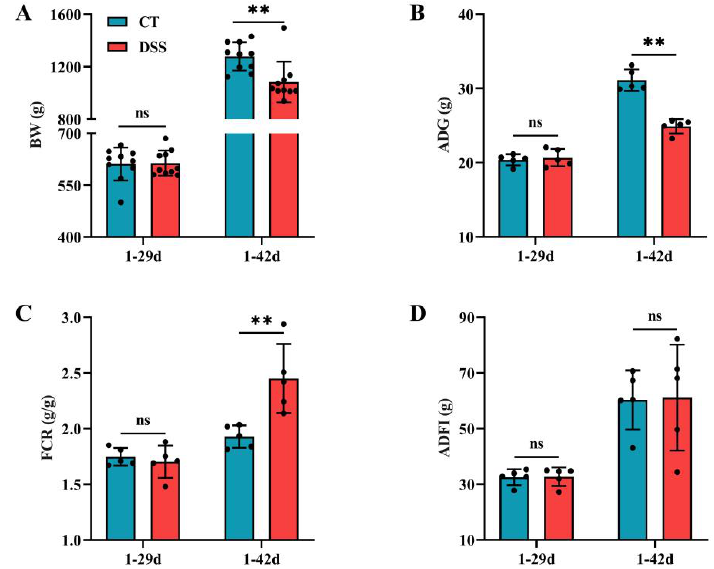
Figure 3. Effects of oral gavage of DSS on the growth performance of broilers: ( A ) BW at two different time points (1–29d and 1–42d) (n = 10 per group); ( B ) ADG at two different time points (1–29d and 1–42d) (n = 5 per group); ( C ) FCR at two different time points (1–29d and 1–42d) (n = 5 per group); and ( D ) ADFI at two different time points (1–29d and 1–42d) (n = 5 per group). Values are means ± SD. ** p < 0.01; ns: not significant ( p > 0.05). BW: body weight; ADG: average daily gain; FCR: feed conversion ratio; ADFI: average daily feed intake.